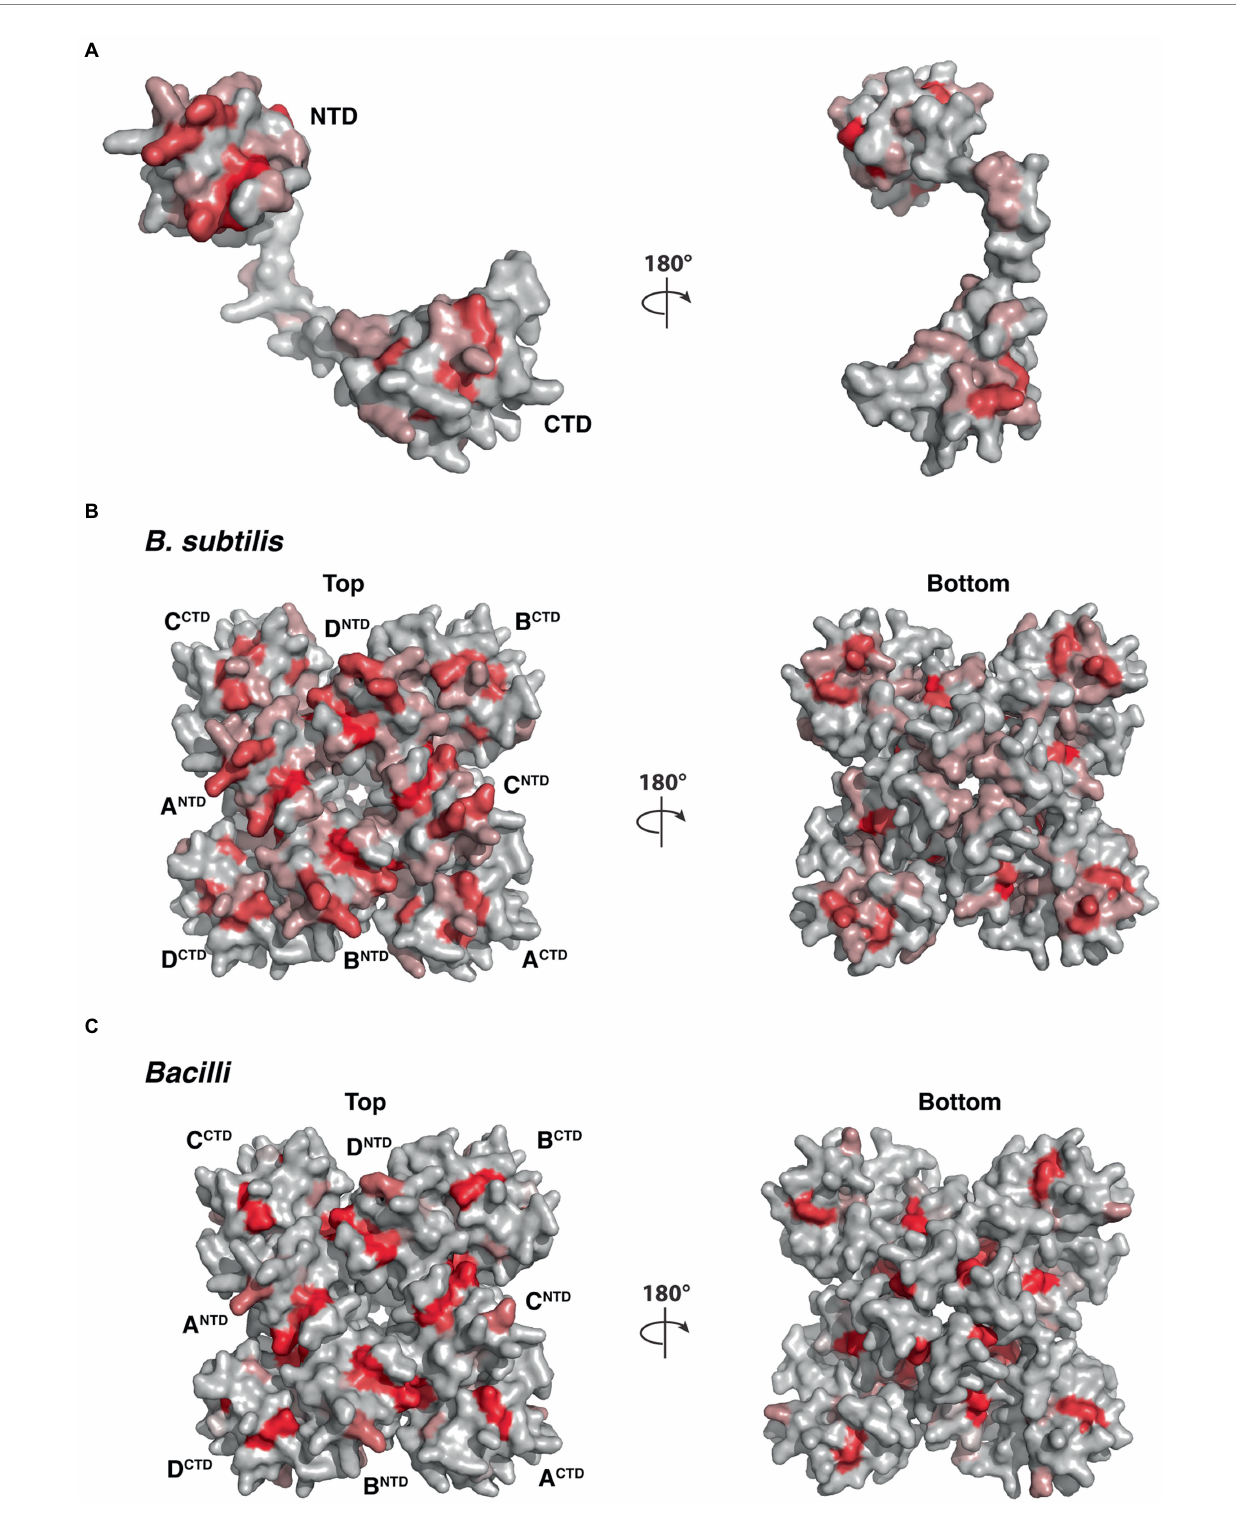
FIGURE 10 Molecular surface of YetF (PDB ID: 3C6F) colored according to homologous amino acid sequence conservation. The colors vary from dark red (highly conserved residues) to light gray (least conserved). (A,B) Surface representation of YetF as a monomer (A) and a tetramer (B) , showing conservation among YetF, YdfS and three other YetF homologs in B. subtilis (see also Figure 1). (C) Surface representation of a tetrameric YetF, showing conservation among best matched YetF homologs identified in other Bacilli as shown in Supplementary Figure